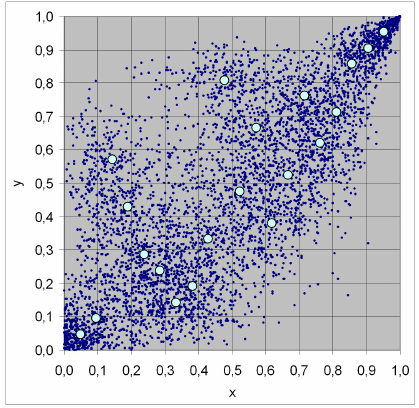
Figure 13: Asymmetric Poisson copula, a = b = 10